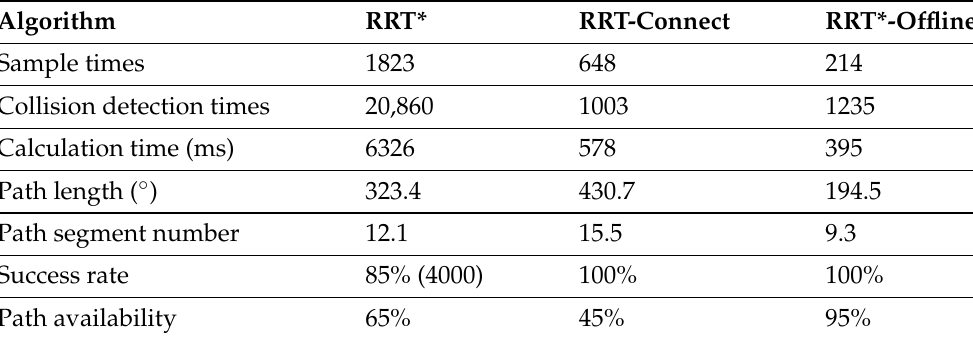
Table 2. Comparison of of different algorithms for motion planning of 6-DOF robots.